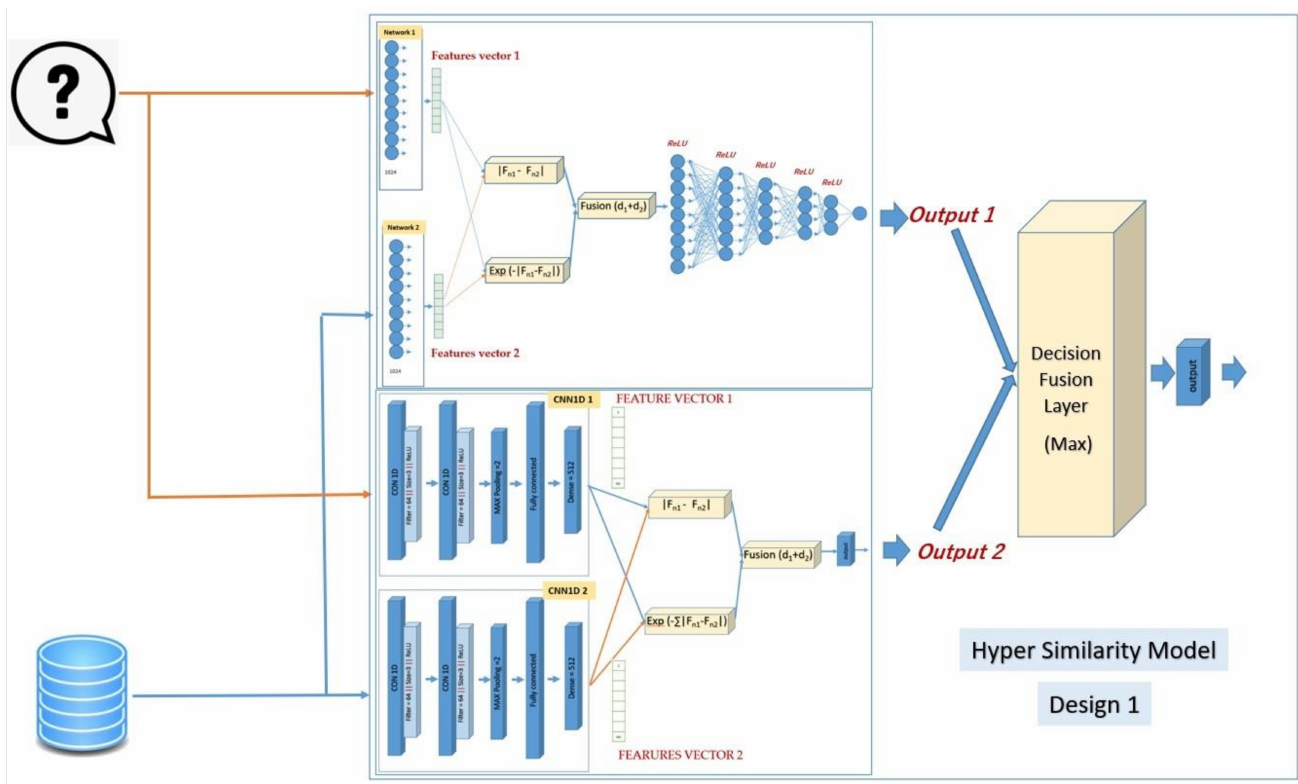
Figure 2. The design of the hybrid Siamese similarity model with two similarity measures using decision